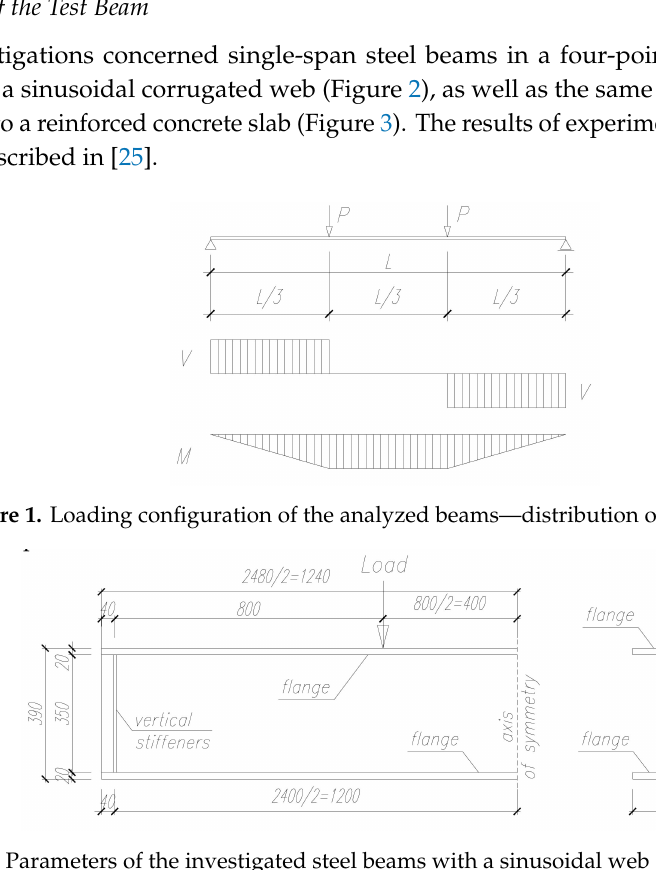
Figure 2. Parameters of the investigated steel beams with a sinusoidal web (dimensions in